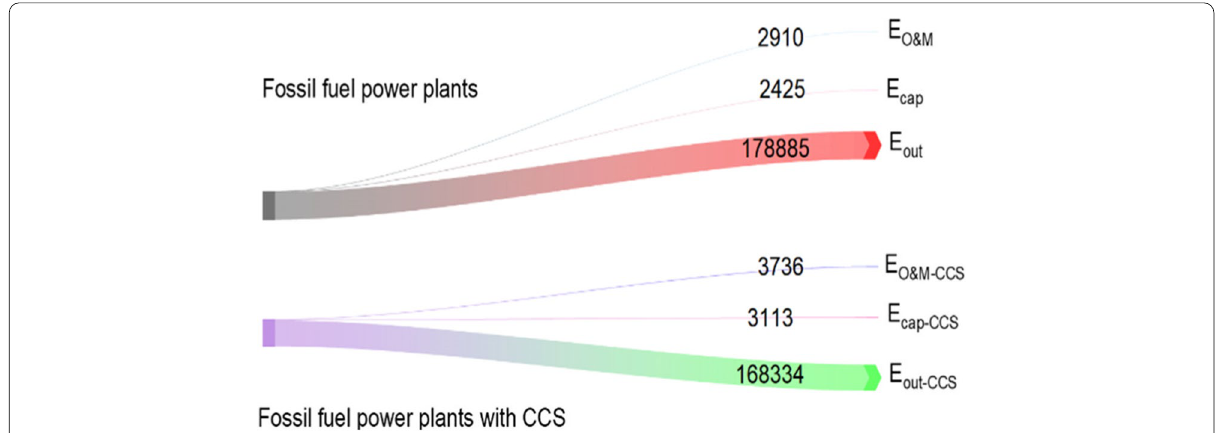
Fig. 6 Energy penalties of fossil fuelled power plant with and without CCS at 85% capacity factor (calculated in GWh)